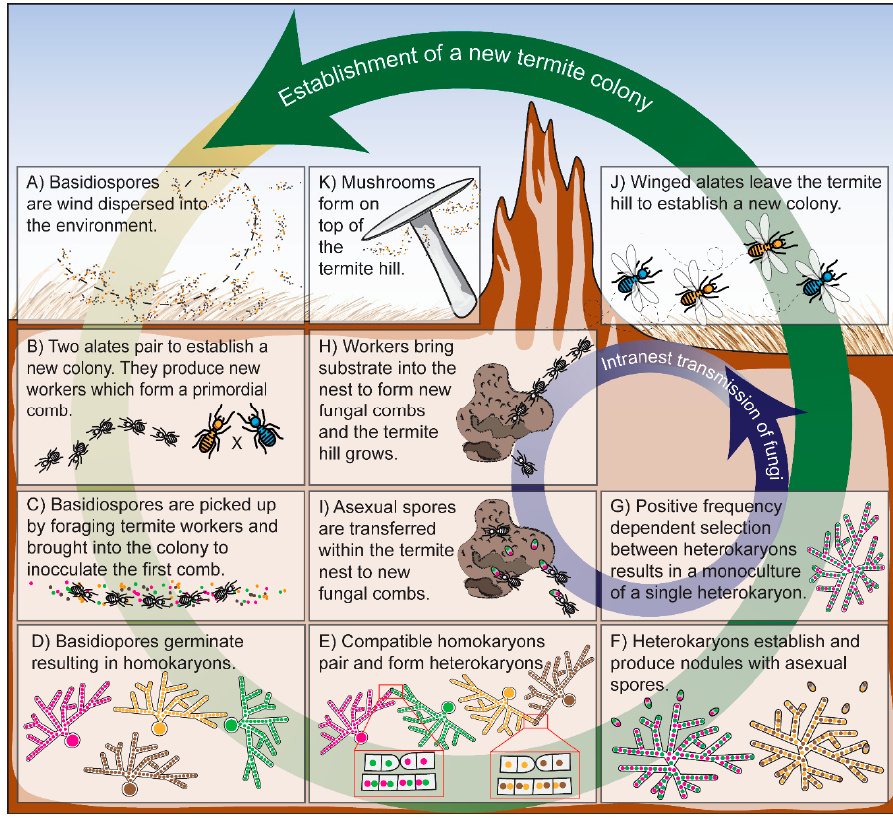
Figure 1. Schematic overview of the establishment of a new termite colony in species with horizontal transmission via sexual spores and the intra-nest transmission of Termitomyces via asexual spores. Most species of macrotermitine termites and their fungal symbionts have horizontal symbiont transmission and reproduce and disperse separately. ( A ) Basidiospores originating from Termitomyces mushrooms are available in the environment after they have been wind-dispersed. ( B ) Two winged alates become the founders of a new termite colony when they pair and become the king and the queen. The king and the queen produce new termite workers, which form a primordial comb. This comb needs to be inoculated with a Termitomyces fungus for the termite colony to survive. ( C ) On one of their first foraging trips, termite workers bring basidiospores of Termitomyces into their nest to inoculate the fungal comb. ( D ) The basidiospores germinate and form homokaryotic mycelia. ( E ) When two compatible homokaryons of the same species meet, they can fuse to form heterokaryotic mycelium in the contact zone, with two nuclei in each cell. ( F ) The heterokaryons grow and produce nodules consisting of asexual spores. During the establishment of the colony, it is possible and likely that more than one heterokaryon is present within the termite nest. ( G ) Positive frequency-dependent selection on the different heterokaryons results in the elimination of fungal genetic variation leading to a fungal monoculture. ( H ) Meanwhile, the termites bring new substrate into the nest and build new fungal combs. While the termite colony grows, the termites ( I ) propagate small amounts of asexual spores which are transferred within the nest to new fungal combs. This intranest transmission is a repeating event which continues as long as the termite colony is active. With bottlenecks imposed by the propagation of asexual spores and positive frequency-dependent selection on the most dominant fungal genotype, the fungal mycelium is kept a monoculture, with no fungal genetic variation in the termite hill. ( J ) Seasonally, the termites form winged alates that disperse to establish new colonies. ( K ) Some time after the winged alates have left the colony Termitomyces starts forming mushrooms. The fruiting bodies of Termitomyces appear on top of the termite hill and disperse large amounts of sexual basidiospores into the environment.